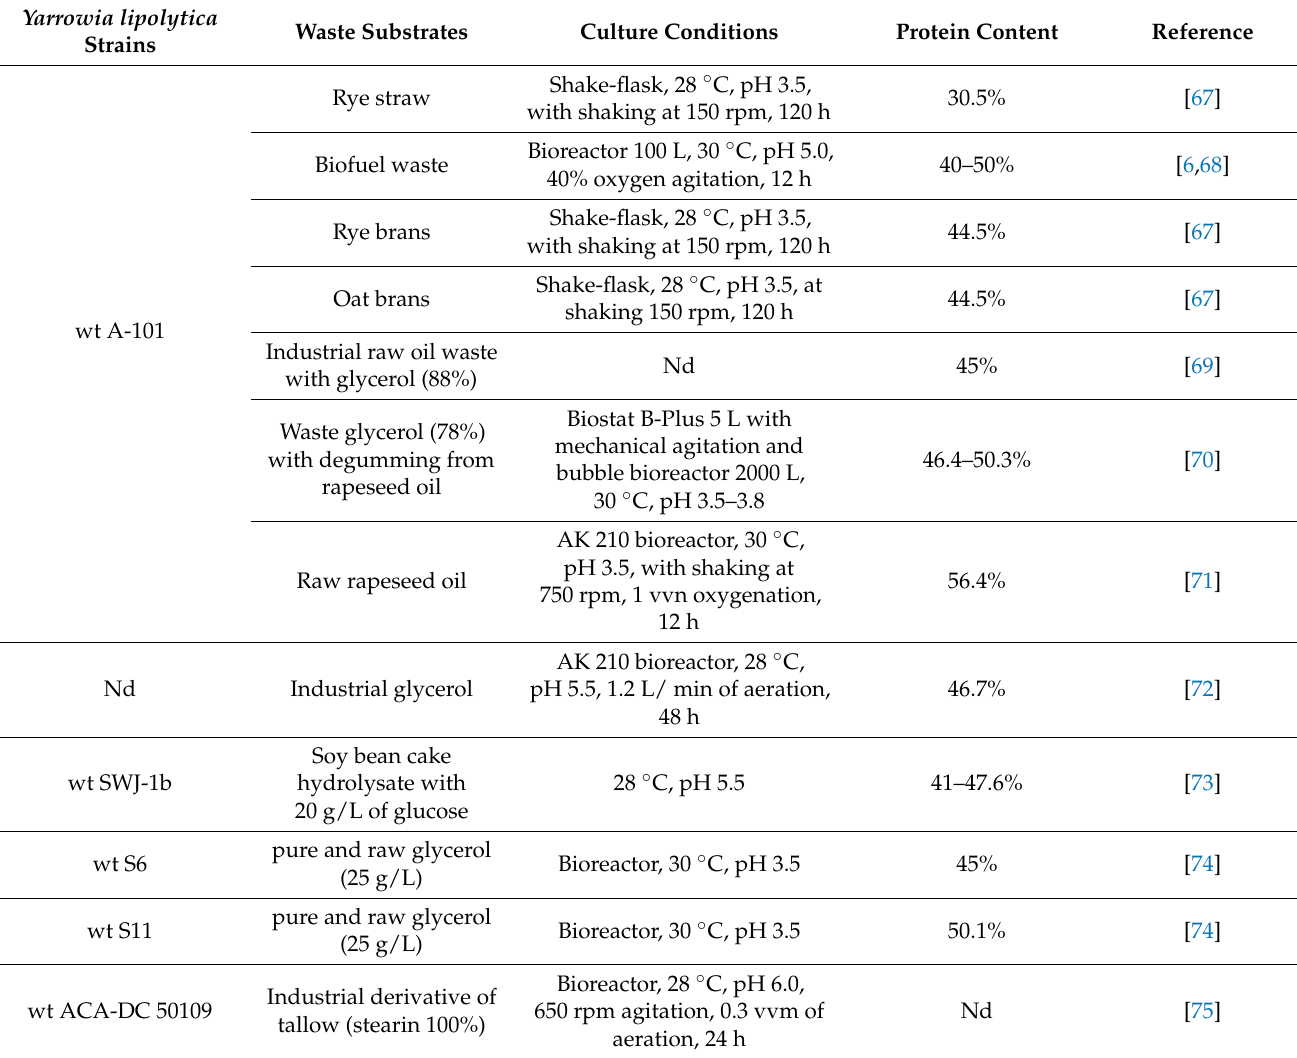
Table 1. Reports of Yarrowia lipolytica strains cultured in specific wastes, culture conditions, and protein